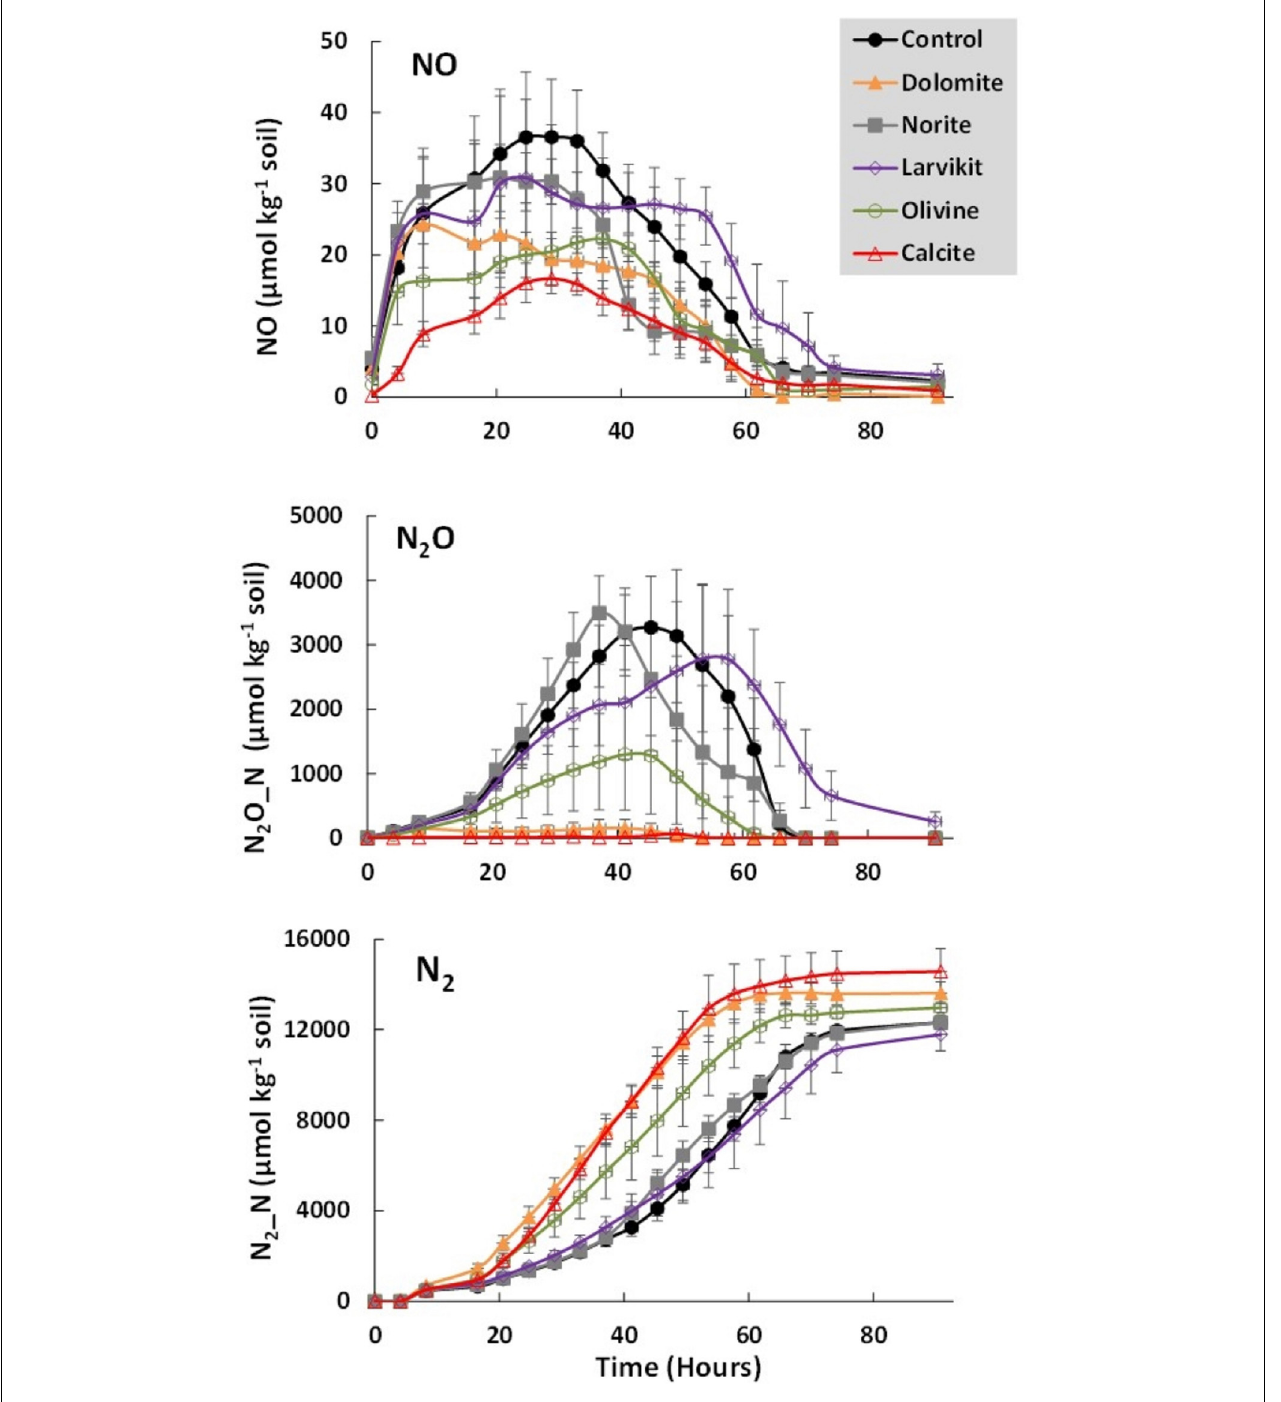
FIGURE 1 | Denitrification in soil slurries. NO and N 2 O are shown as measured, while N 2 is the cumulative production (measured values corrected for sampling loss, see Molstad et al., 2007). Plotted values are means and standard errors of four field-replicates for each treatment, sampled 27 months after mineral applications in the field experiment. Samples taken 15 months after mineral treatment showed very similar response to soil pH whereby the N 2 O production index ( I N 2 O ) declined with soil pH. I N 2 O for individual soil samples in both experiments are shown in Supplementary Figure 4 .